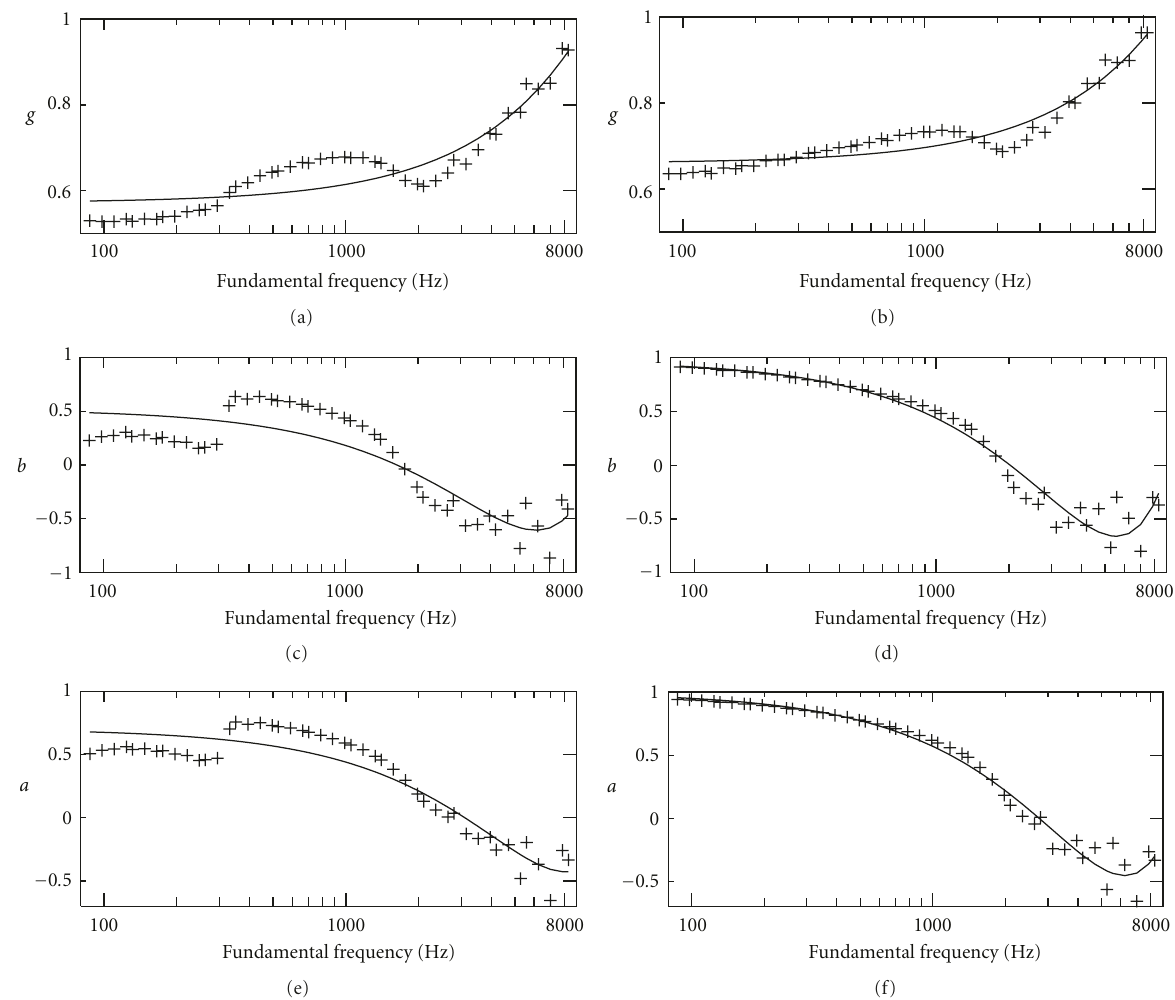
Figure 10: Filter parameter estimates (plus signs) of (a), (b) the gain factor g , (c), (d) the filter zero b , and (e), (f) the filter pole a for the second- and fourth-order DPW oscillator, respectively. The polynomial approximations of the filter parameters are given with solid lines. and fourth-order DPW algorithms are shown in Figures as indicated in Figure 13 for the filtered fourth-order BLEP 12(e) and 12(f) with a solid and a dashed line, respectively. oscillator. Similar observations were made for all